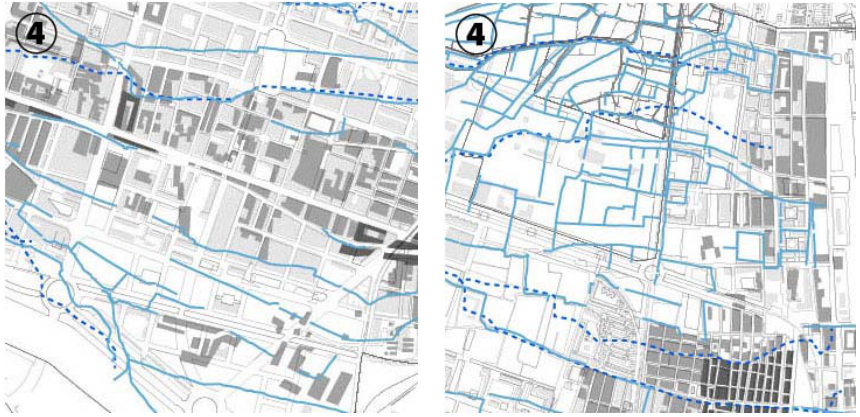
Figure 8. In the areas labeled as ④, the canals developed during the period between 1883 and 1946.